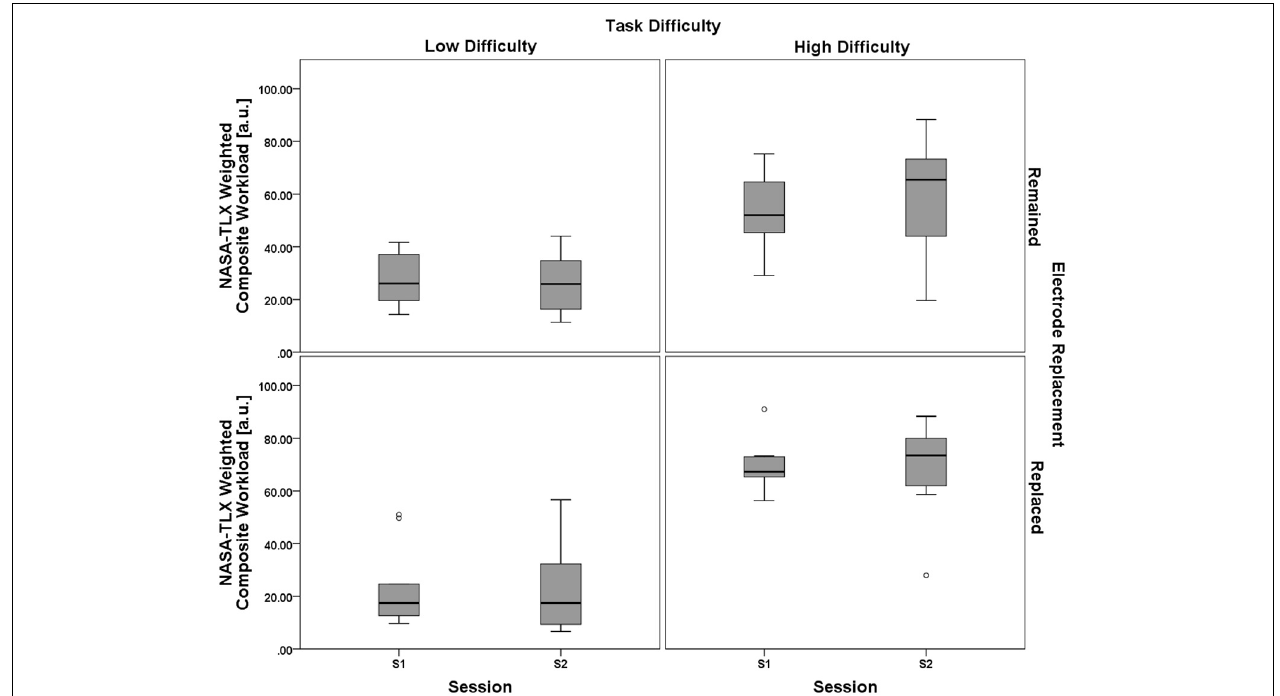
FIGURE 9 | Boxplots showing NASA-TLX Weighted Composite Workload scores representative of the 2 (task difficulty, within) × 2 (session, within) × 2 (electrode replacement, between) mixed model ANOVA results. The only significant effect from all main effect and interaction tests was a main effect of task difficulty on NASA-TLX subjective workload ratings. Results of the subjective workload assessment confirm that there was a significant workload difference between the two task difficulty conditions. Otherwise subjective workload